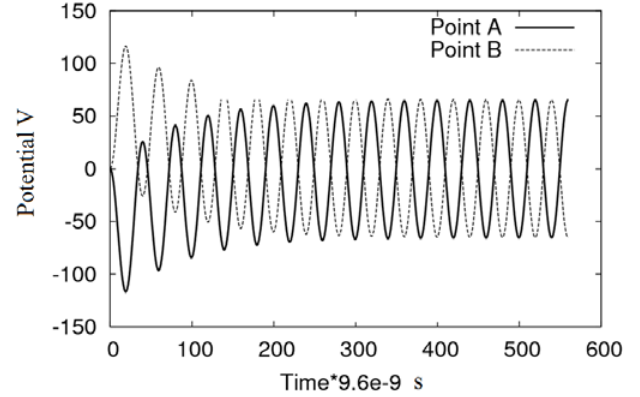
Figure 7. Transitory state of the potential at the interface in points A and B.